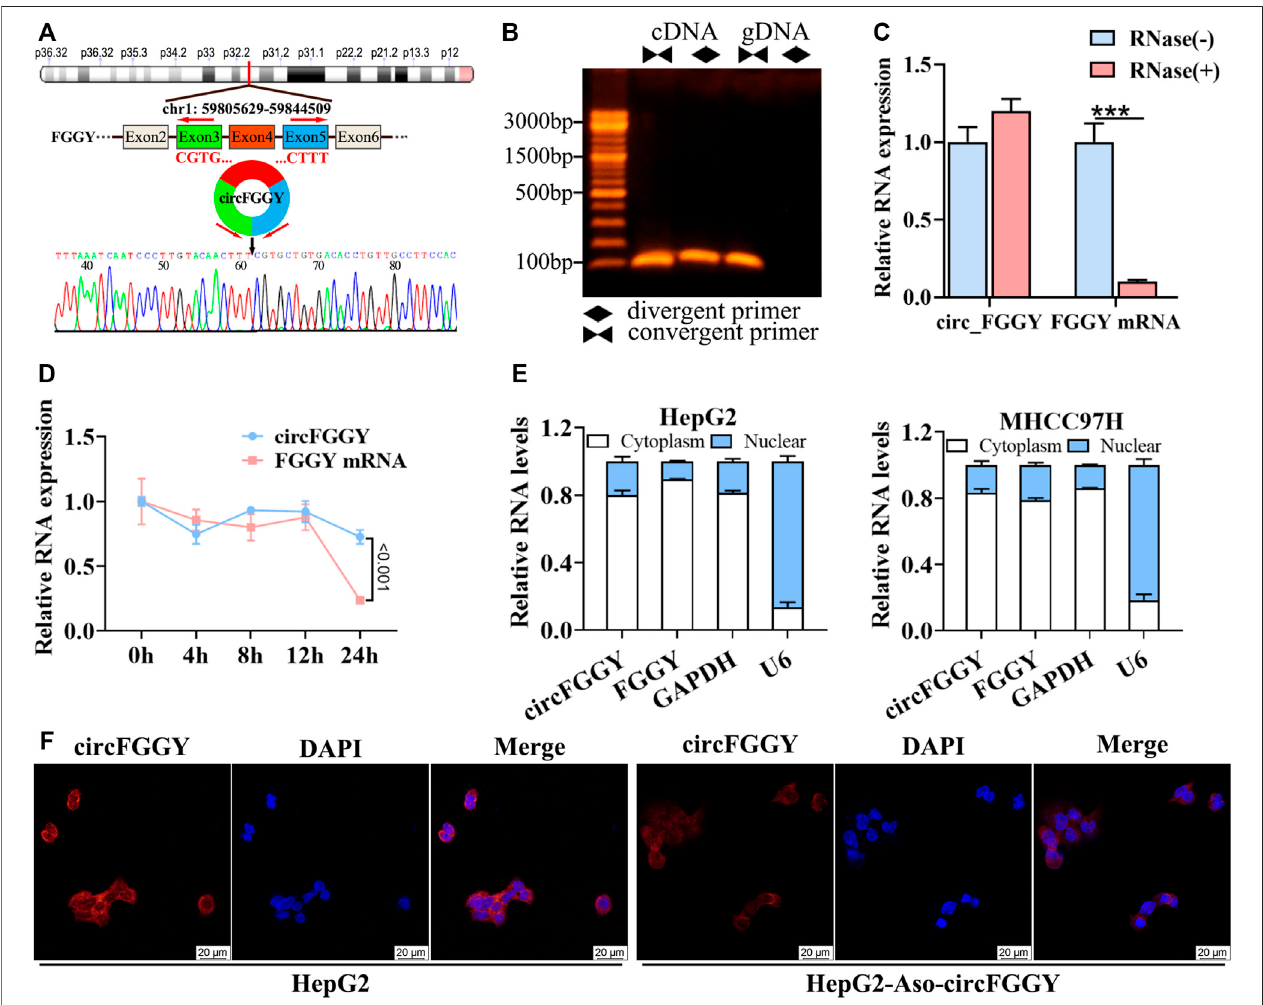
FIGURE2| CellularlocalizationandstabilityofcircFGGYinHCCcells. (A) SchematicsshowingthegenerationofcircFGGY.PCRprimersusedtospeci fi callydetect circFGGY by qRT-PCR are indicated by red arrows. Black arrow indicates regions that were Sanger-sequenced and identi fi ed as the breakpoint of circFGGY. (B) CircFGGY can be ampli fi ed by the divergent primers in cDNA, but not ingDNA. (C,D) qRT – PCR analysis forthe RNA expression ofcircFGGY and FGGY after treatment withRNase RorActinomycinD(5 ug/ml)attheindicatedtimepoints inHepG2cells.Datawereshown asmean±SD, n =3.*** p < 0.001inindependentStudent ’ s t test (C) or two-way ANOVA (D) . (E) circFGGY and FGGY are abundant in the cytoplasm of HepG2 and MHCC97Hcells. GAPDH and U6 were applied as positive controls in the cytoplasm and nucleus, respectively. (F) In situ hybridization showing the subcellular localization of circFGGY in HepG2 cells. The circFGGY probe was labeled with Cy3. Nuclei were stained with DAPI. Scale bar, 20